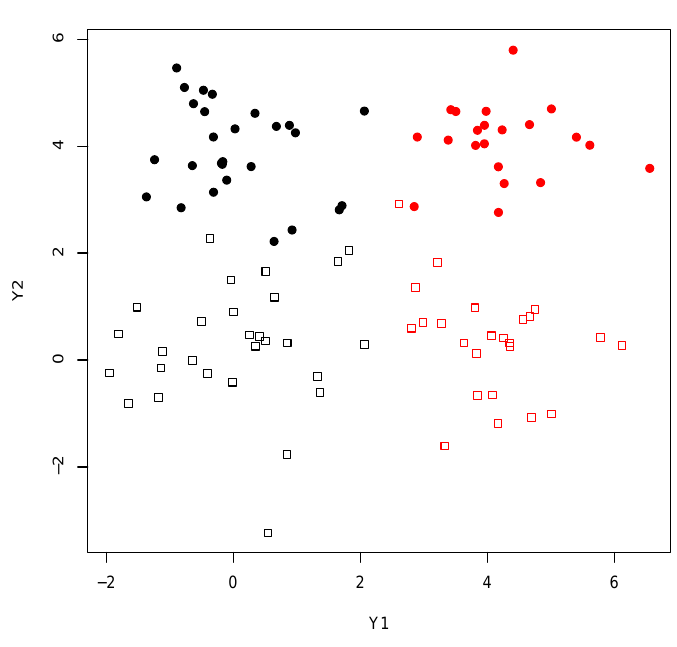
Figure 4. Scatter plot of the illustrative data on the two original clustering